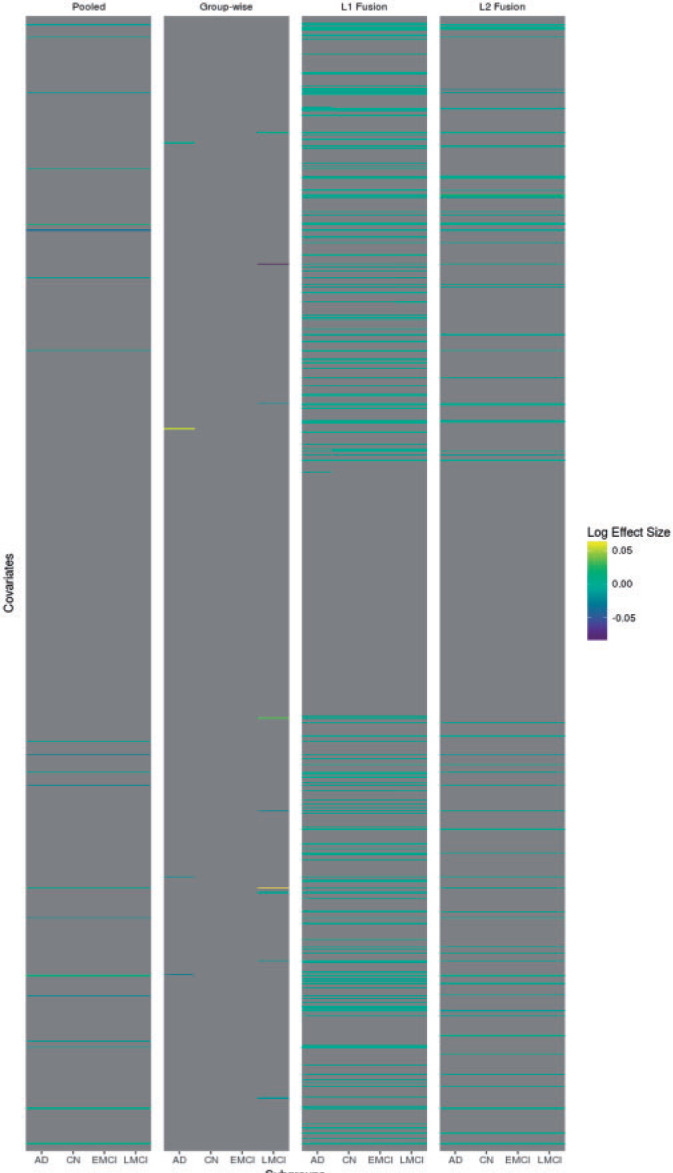
Alzheimer’s disease data, estimated regression coefficients. Heatmap showing estimated regression coefficients for a representative subsample of the SNPs. Absolute coefficients are thresholded at \documentclass[12pt]{minimal}
\usepackage{amsmath}
\usepackage{wasysym}
\usepackage{amsfonts}
\usepackage{amssymb}
\usepackage{amsbsy}
\usepackage{upgreek}
\usepackage{mathrsfs}
\setlength{\oddsidemargin}{-69pt}
\begin{document}
}{}$e^{-2}$\end{document} to improve readability.